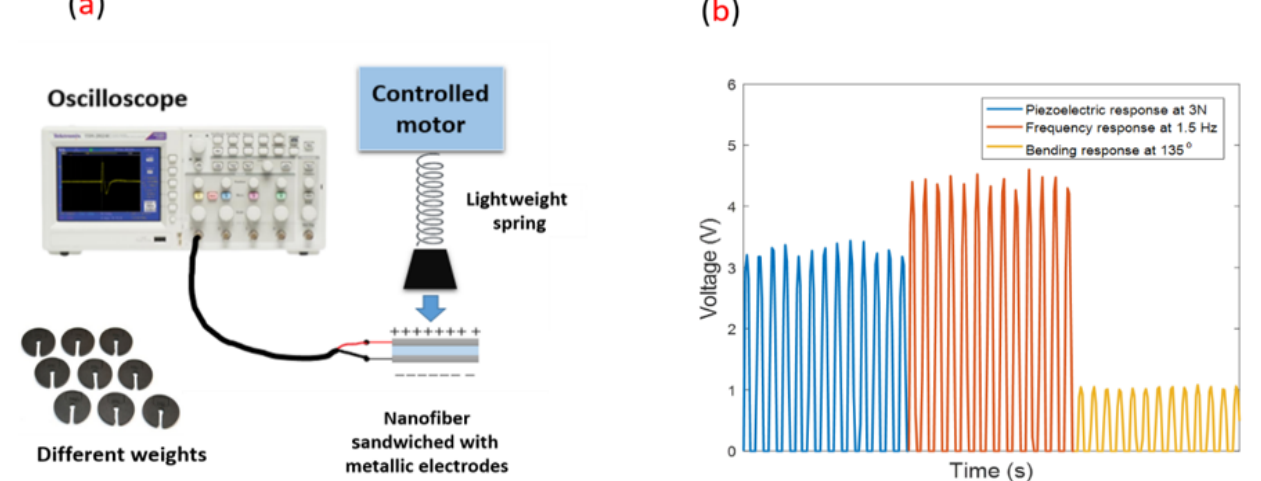
Figure 6. ( a ) Schematic of the piezoelectric characterization under applied force mechanical excita- tions. ( b ) The oscilloscope signals for the piezoelectric response at 3N, the frequency response at 1.5 Hz, and the bending response at 135°.